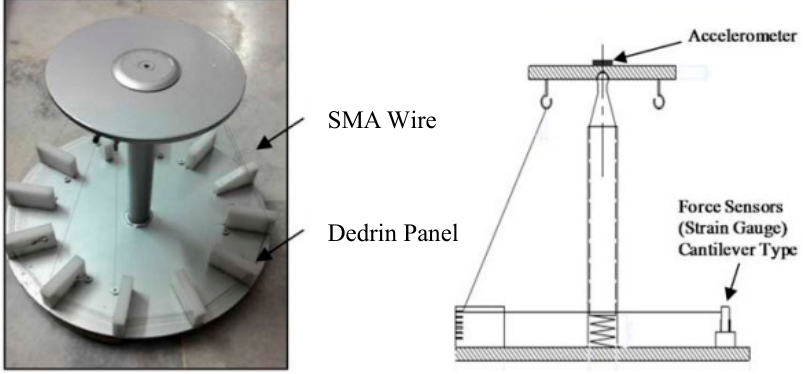
Figure 35. The SMA wires actuated Stewart platform rehabilitation device [61].